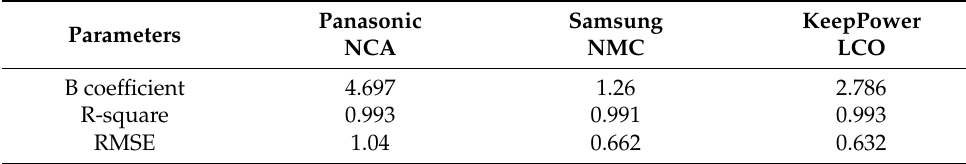
Figure 7. Thermal maps obtained from the proposed equation. Table 3. Fitting parameters.